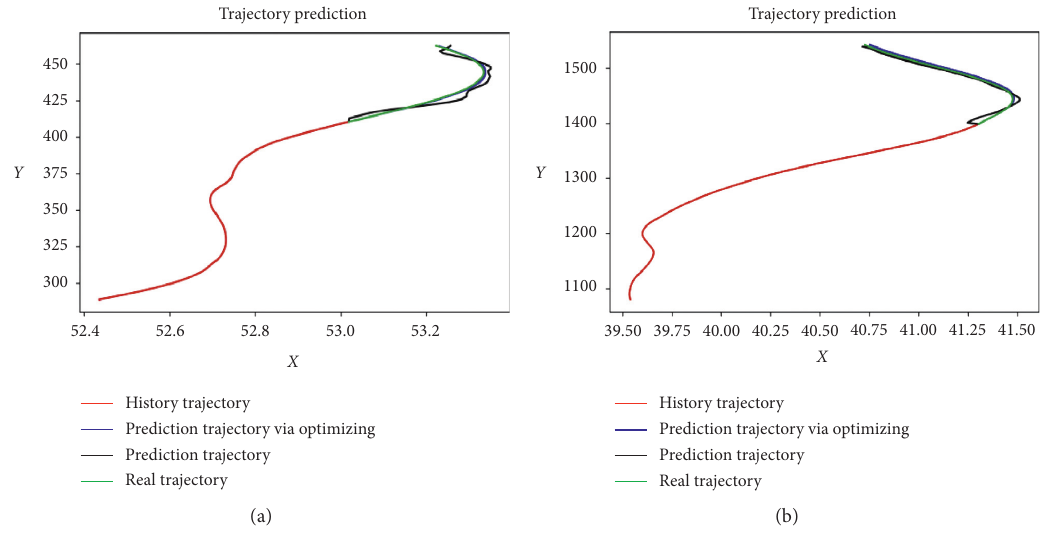
Figure 9: Trajectory prediction results using the two models in parallel. (a) Prediction trajectory 1. (b) Prediction trajectory